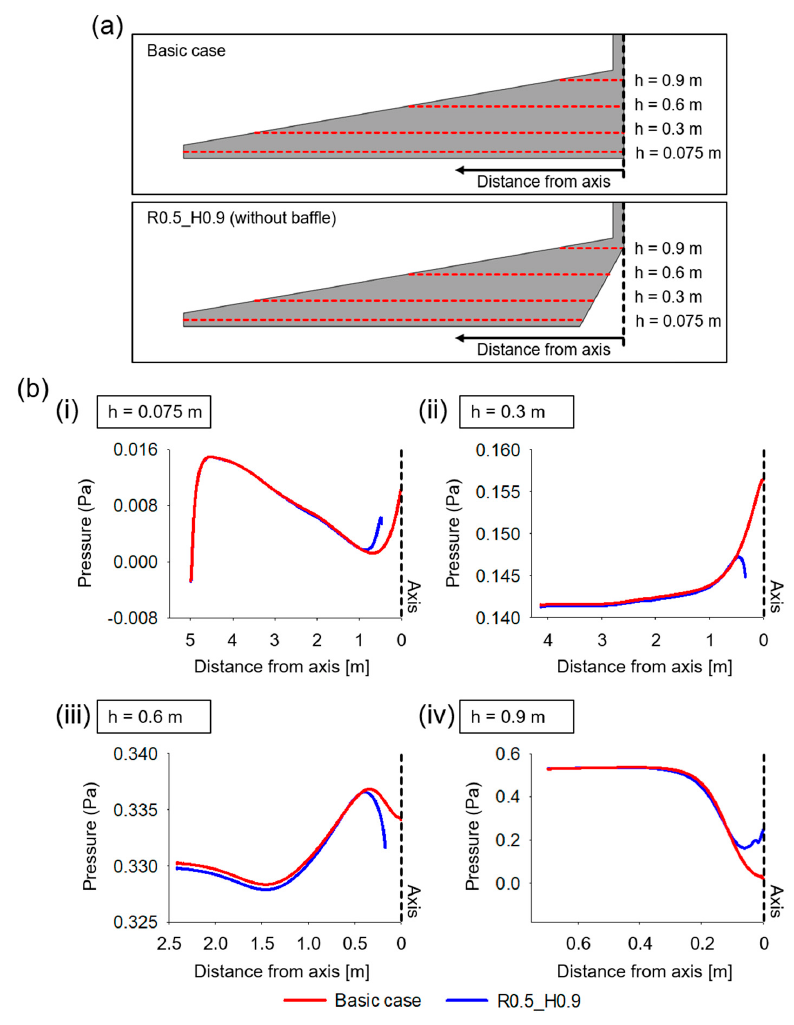
Figure 3. Effect of the CGP on the pressure distribution. ( a ) Observation line of the pressure profile (red line). ( b ) Pressure profile in ( i ) h = 0.075 m, ( ii ) 0.3 m, ( iii ) 0.6 m, and ( iv ) 0.9 m.